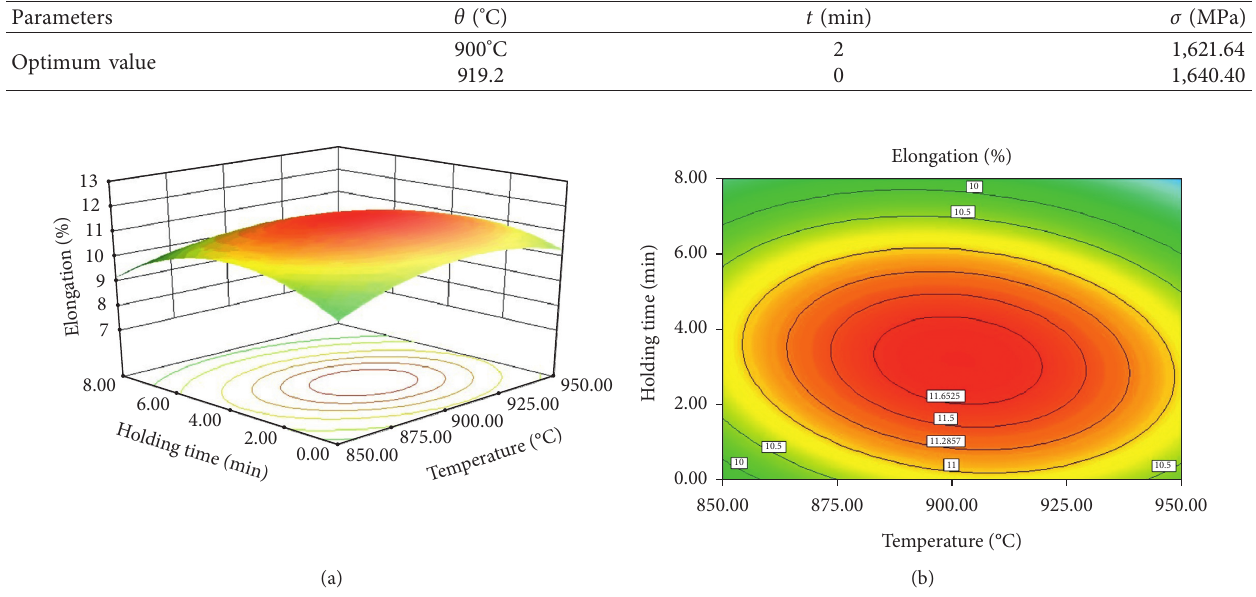
Table 9: Maximum values for tensile strength.